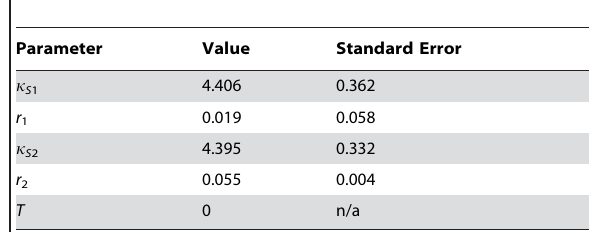
Table 2. The parameter values used in the model for the vector uptake and development functions. These values were obtained through nonlinear least squares fits from the data collated by Snow and Michael